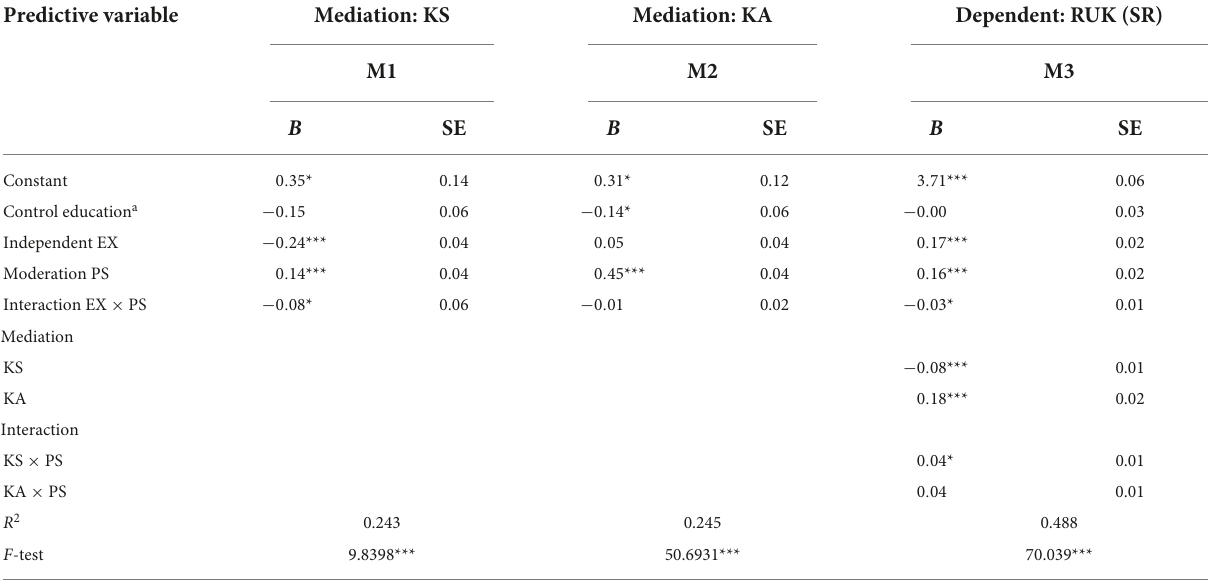
TABLE 3 Analysis of the moderating effect of political skills to experience on receiving useful knowledge (self-report).